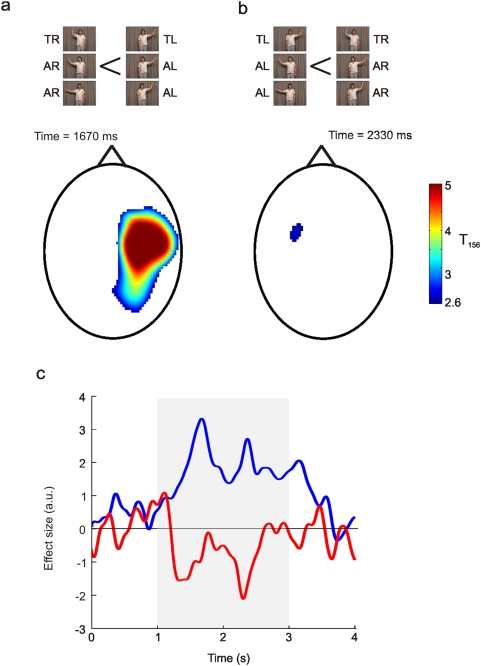
Sensor space statistical parametric maps.Figure 2a shows the statistical parametric map where beta power was smaller when observing a right handed action then when observing a left handed action in sensor space. Figure 2b shows the statistical parametric map for the interaction between the hand observed and the direction the actor's head was facing. The colour-scale in both (a) and (b) depicts the t-value. These statistical maps were thresholded at p<0.005 (uncorrected). Figure 2c shows the time course of the betas (a.u.) averaged across voxels that were above the p<0.005 threshold that are shown in panels (a) and (b). The blue line shows the time course for the beta value for the contrast shown in panel a The red line shows the time course for the beta value for the contrast shown in panel b. The grey box shows the period of action observation. TR – towards right hand, TL – towards left hand, AR – away right hand, AL – away left hand. It should be noted that the reciprocal nature of the modulations in the left and right hemisphere can not simply reflect extrema of classic dipolar field patterns as here we consider sensor space maps of power where the data has been squared and, therefore, is always positive.